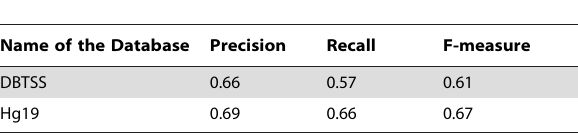
Table 4. Prediction Performance of our proposed method using grammar rules on two datasets DBTSS and sequences from UCSC table browser for HG19.